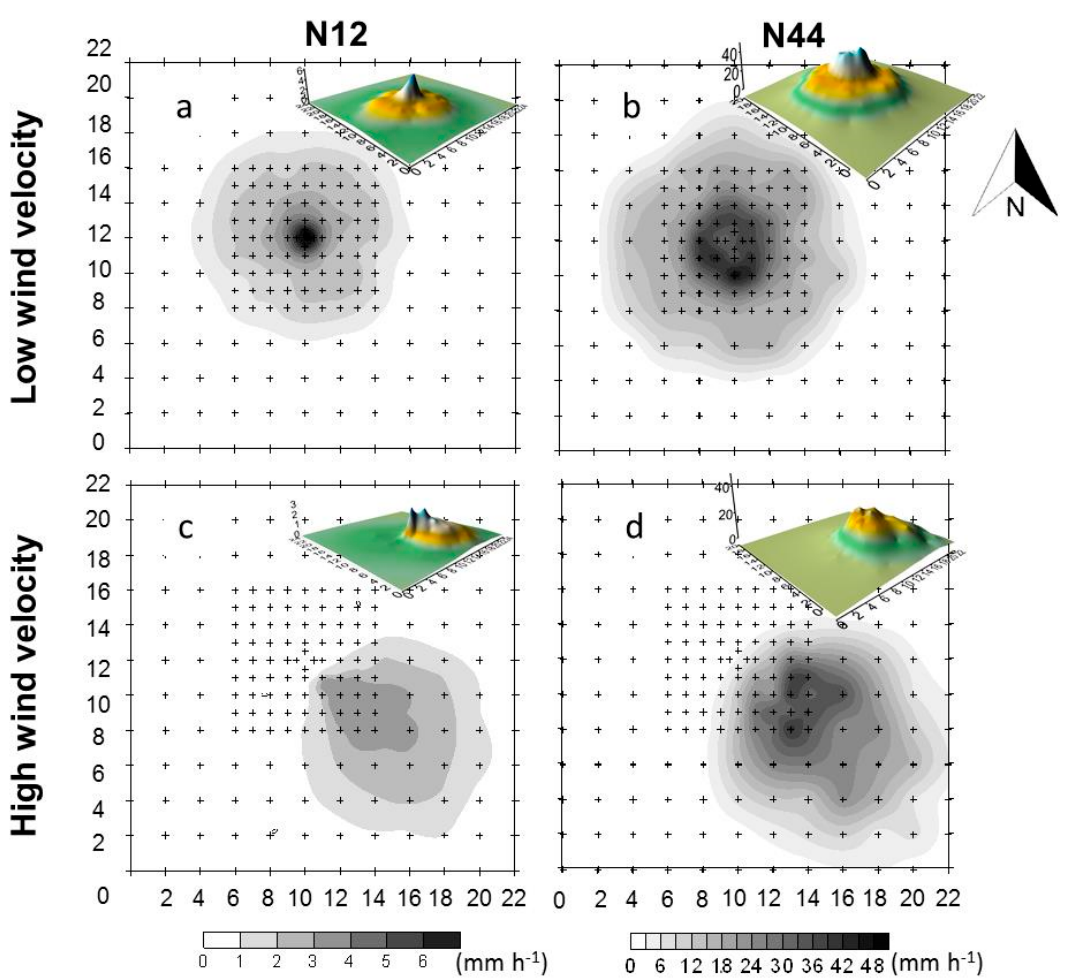
Figure 3. Measured water distribution at 103 kPa for the nozzle N12 (2.4 mm) and nozzle N44 (8.7 mm) for calm conditions ( a , b ) and windy conditions ( c , d ).